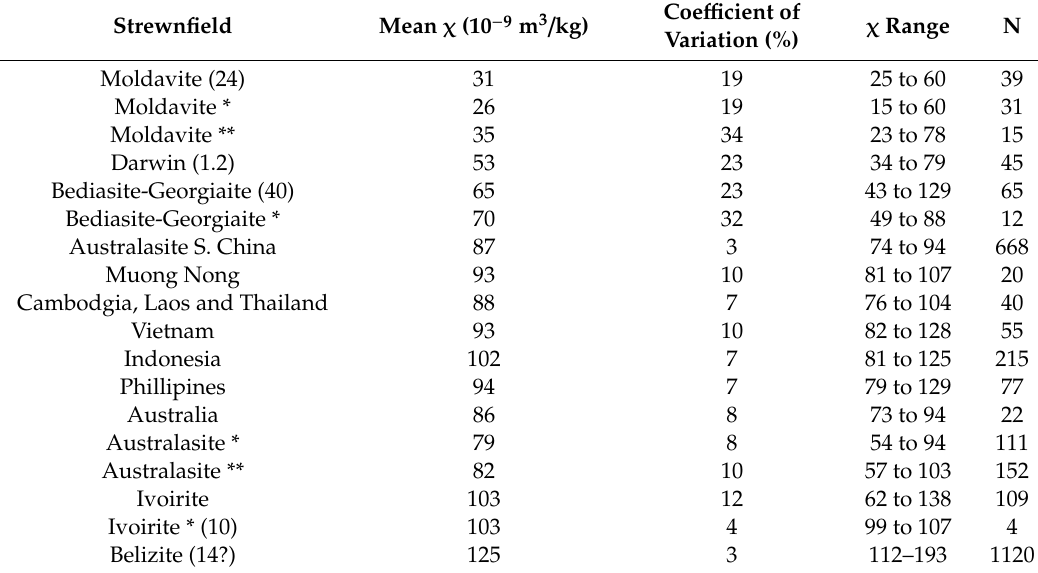
Table 1. Magnetic susceptibility of tektites and Darwin glass ordered by FeO amount after [9] and this work, excluding anomalies over two times the average for australasite and belizite (see text). * and **: comparison with data from [20] and [21]. N is number of measurements (can be pooled specimens, or several specimens from one sample). When known the diameter in km of the source crater is indicated within brackets.